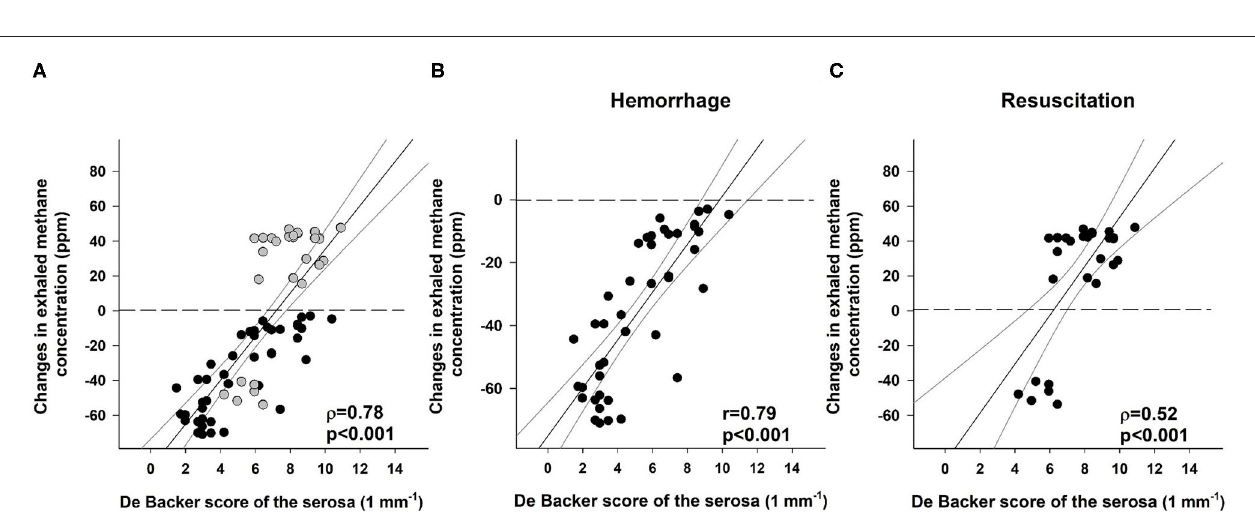
FIGURE 5 | Correlation between the De Backer score (1 mm − 1 ) for the serosa and changes in exhaled methane concentration (ppm) during the whole course of experiments ( A ; black scatters show the data collected during bleeding, and gray scatters show the data recorded during resuscitation), the hemorrhage ( B ; black scatters) and resuscitation phases ( C ; black scatters). The plot demonstrates the regression line (black line) and corresponding r and ρ values as indicators of the strength of the linear correlation and p significance